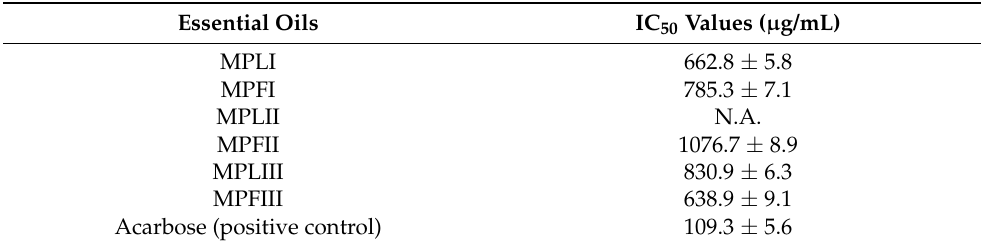
Table 3. α -Amylase inhibitory activity of EOs from the three sites (MP-I, MP-II, MP-II) (L = leaf; F =